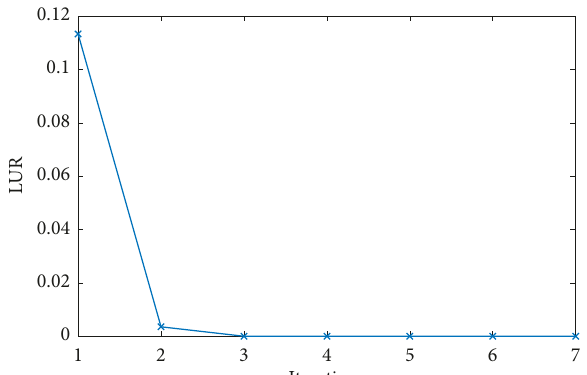
Figure 5: Relationship between the iterations of the LSQR algorithm and the LUR.